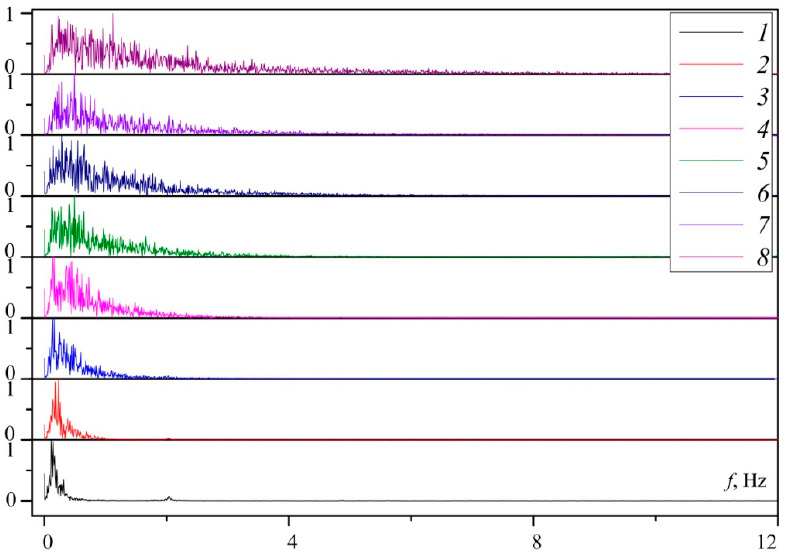
Figure 12. Spectra of temperature pulsations at different currents. Maxwell coil is turned on. 1 —100